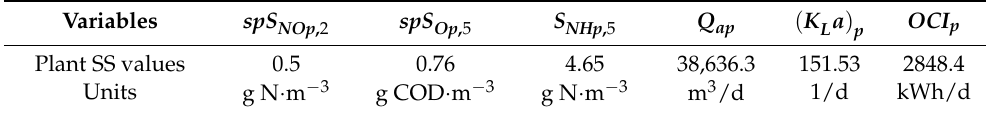
Table 5. Plant steady-state values at model